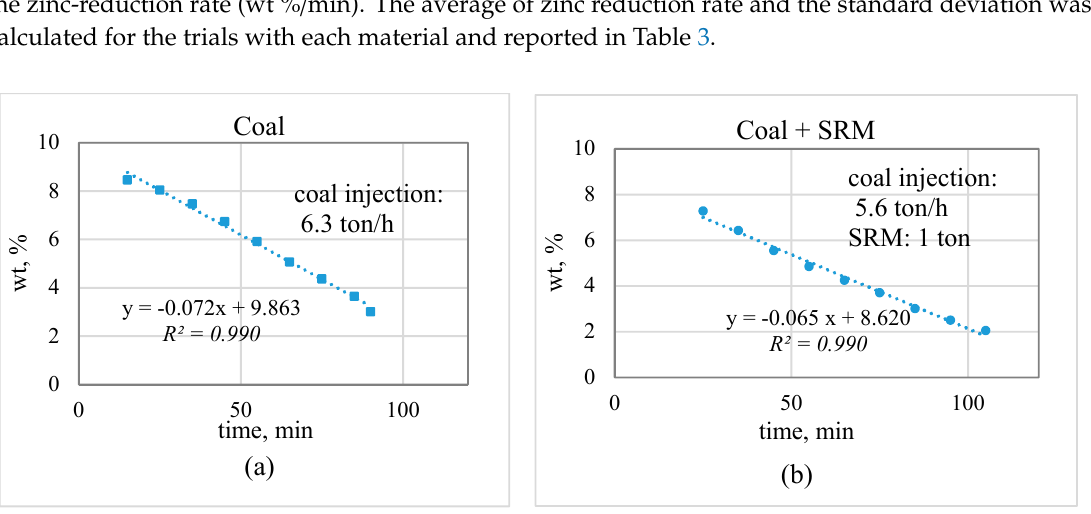
Figure 7. Zinc-reduction rate with ( a ) coal injection, ( b ) the co-injection of coal and SRM.